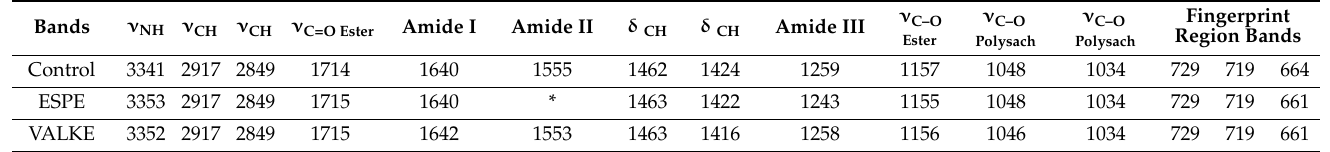
Table 4. Assignments of main vibrational bands (cm − 1 ) of maize